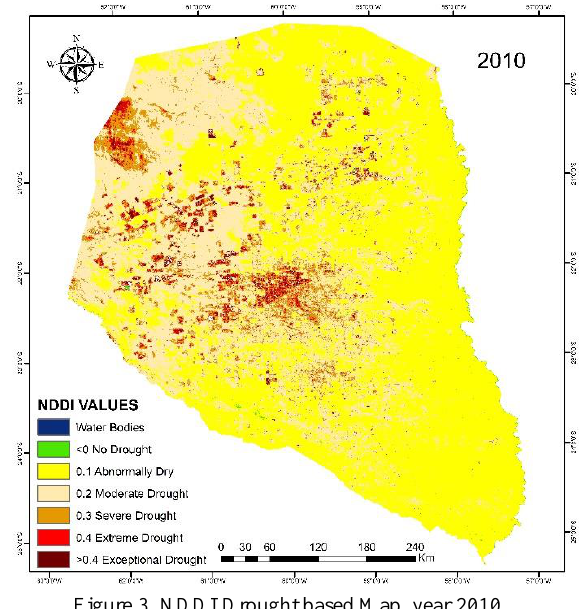
Figure 3. NDDI Drought based Map, year